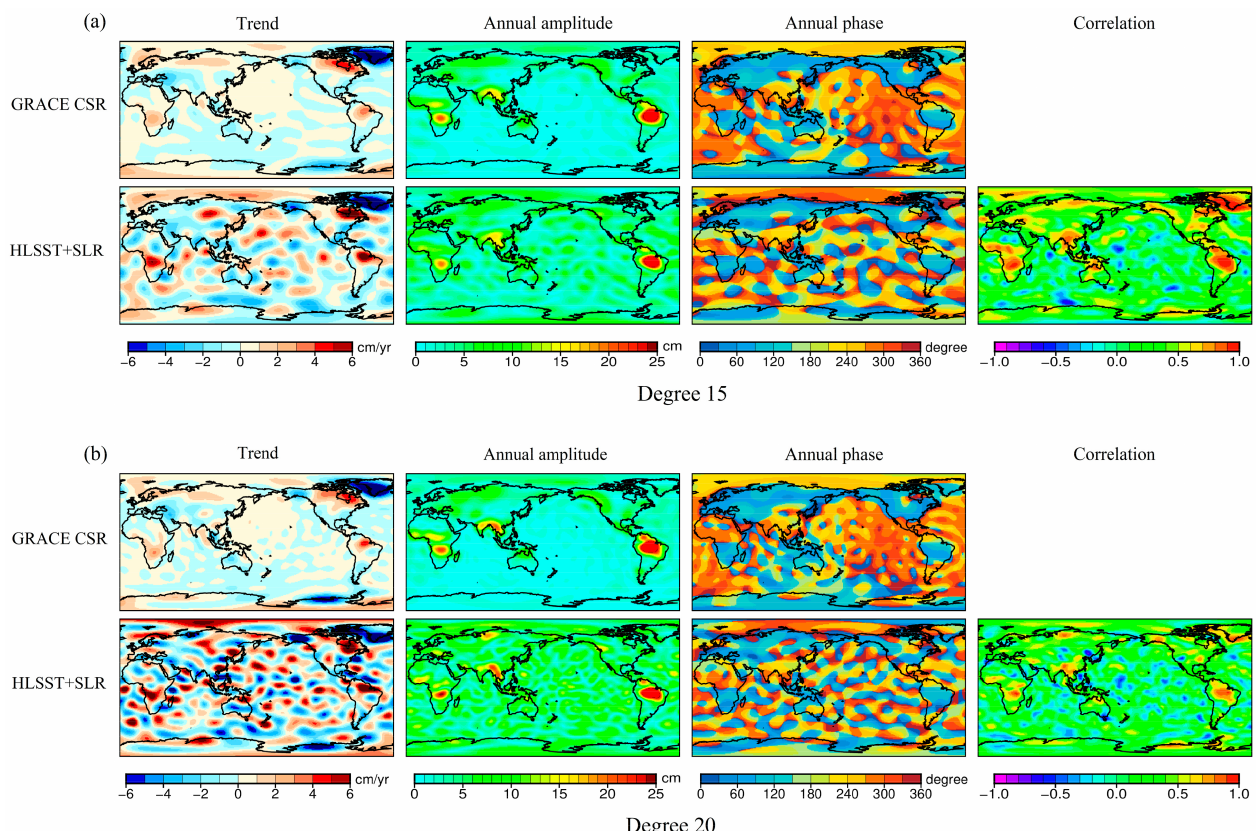
Figure 7. Trend, annual amplitude, and phase of mass variations derived from GRACE CSR monthly and HLSST+SLR monthly solutions in terms of centimeters of water height equivalent. Spatial correlations of mass change from HLSST+SLR with standard GRACE CSR are in the fourth column. ( a ) Coefficients of both solutions are truncated to degree 15. ( b ) Coefficients of both solutions are truncated to degree